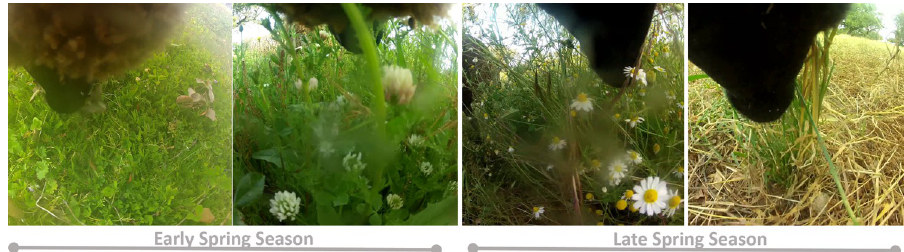
Fig 9. Screenshots of ewes’ dietary choices (feeding niches) in early and late spring. (1) Eating holm oak ( Quercus rotundifolia [Lam.]) dry leaves; (2) eating legumes ( Trifolium vesiculosum ); (3) eating forbs ( Chamaemelum spp.); (4) eating grass ( Poa spp.) (note the differences in sward height and colour).